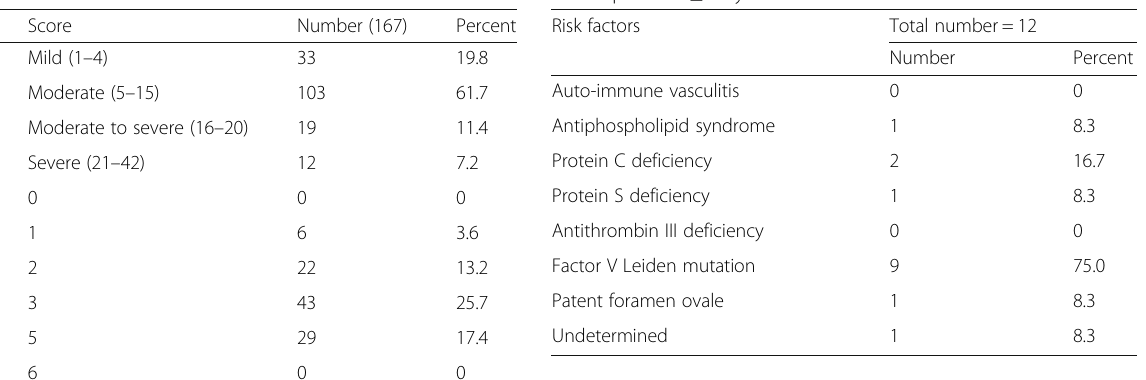
Table 4 Distribution of additional risk factors in 12